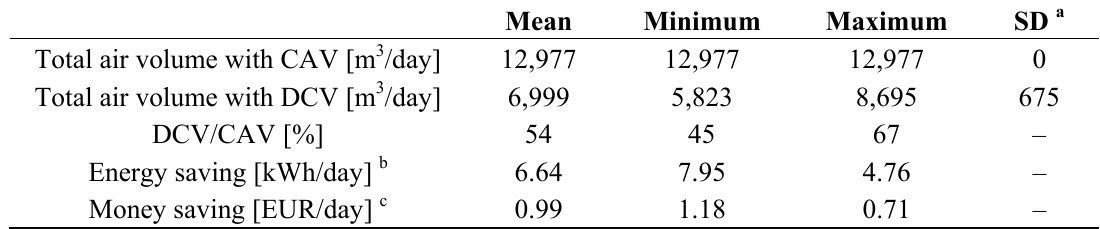
Table 2. Characteristics of the comparison between the visitor counting sensor-based DCV and CAV. It was assumed that the ventilation system operated round the